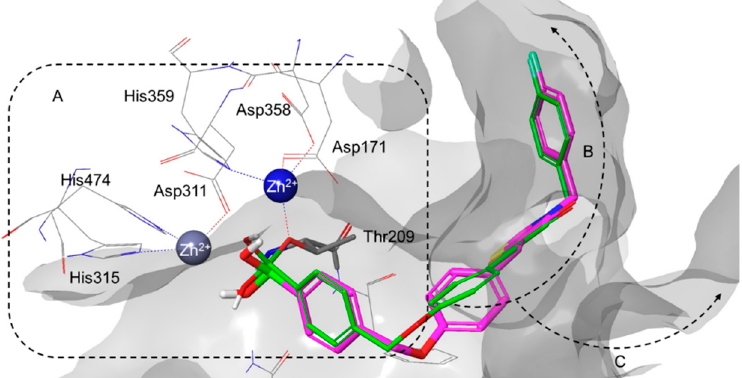
Figure 6. Overlay of HA155 boronic acid (green) inhibitor in the binding site of ATX (Protein Data Bank (PDB) ID: 2XRG [9] and re-docked pose of HA155 (magenta) using Covalent Docking v1.3. [15].